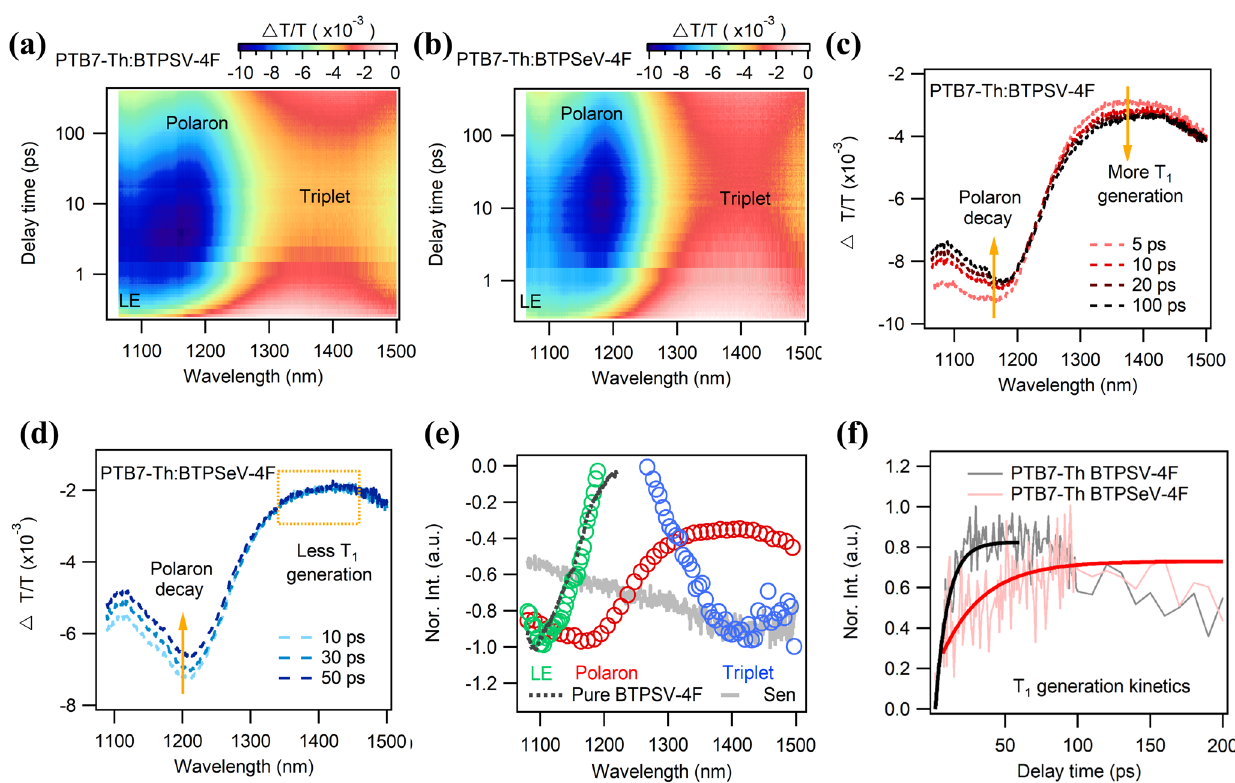
Fig. 3 | Triplet generation dynamics of blend fi lms in NIR-TA spectra. a , b 2D color plot of TA spectra of PTB7-Th:BTPSV-4F fi lm and PTB7-Th:BTPSeV-4F fi lm under 900nm excitation at ~10 μ J/cm 2 . c TA spectra of PTB7-Th:BTPSV-4F at the indicated delay times in NIR region. d TA spectra of PTB7-Th:BTPSeV-4F at the